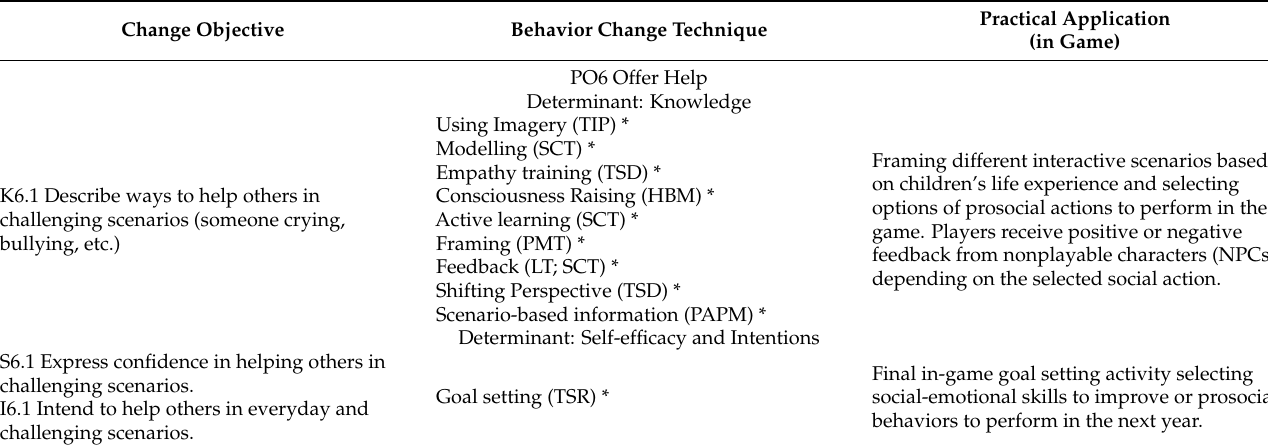
Table 4. Examples of Change Methods and